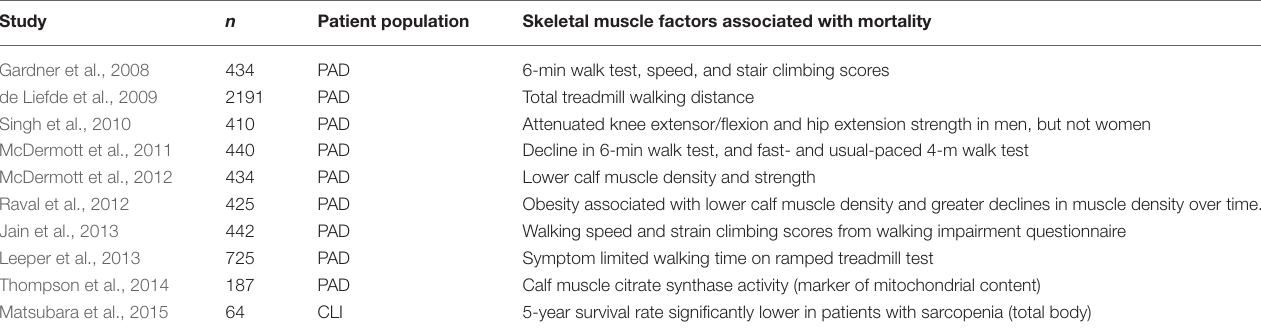
TABLE 1 | Clinical studies implicating skeletal muscle function with mortality. Study n Patient